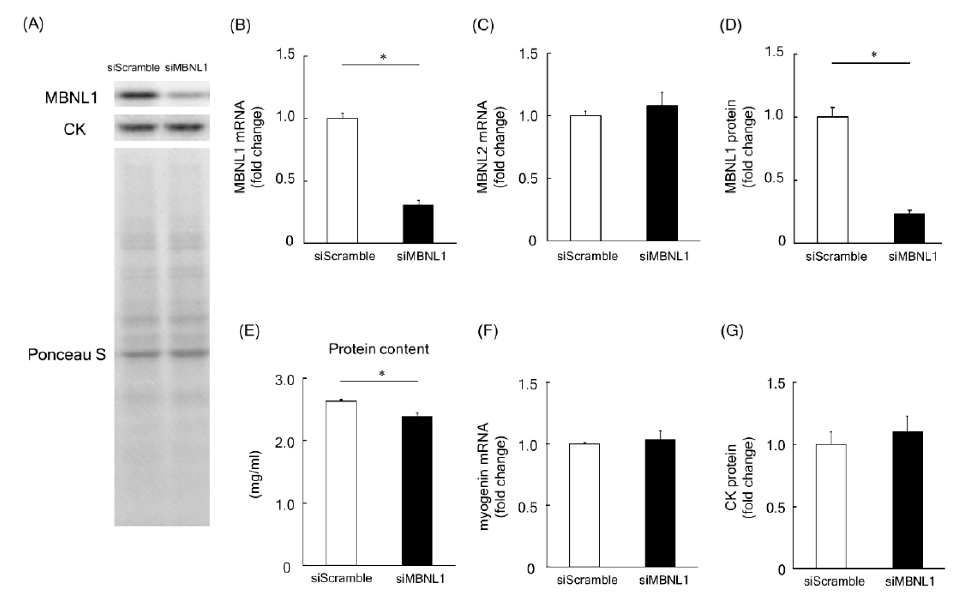
Figure 1. Effects of muscleblind-like 1 (MBNL1) knockdown on differentiation of C2C12 myotubes. ( A ) Representative expression patterns of MBNL1, Creatine kinase (CK), and loading control Ponceau S staining. mRNA expression level of MBNL1 ( B ) and MBNL2 ( C ). ( D ) Protein expression level of MBNL1. ( E ) Muscle protein content in 5 days after differentiation. The expression level of myogenin mRNA ( F ) and CK protein ( G ). siScramble: scrambled nontargeting small interfering RNA (siRNA), siMBNL1: targeting siRNA for MBNL1. Values are means ± standard error of the mean (SEM); n = 6 per group. *: p < 0.05.